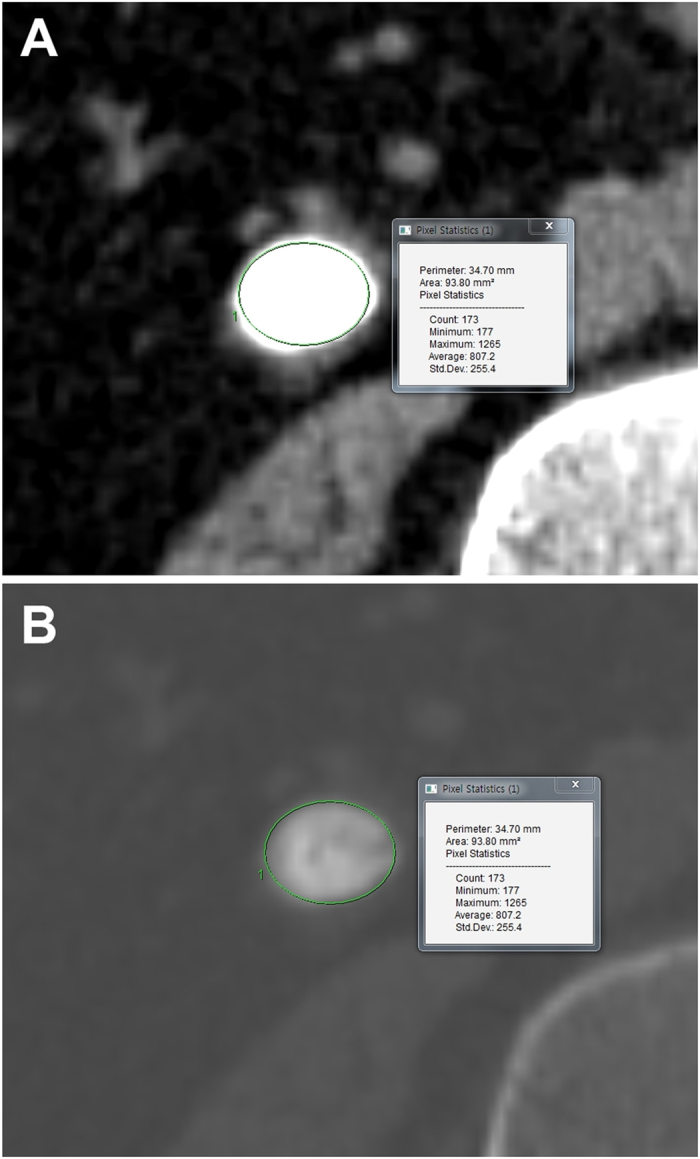
Measurement of stone heterogeneity index (SHI) on axial images of non-contrast computed tomography (NCCT).(A) Soft tissue setting view, (B) Bone setting view (Mean stone density = 807.2 HU and Stone heterogeneity index = 255.4 HU).